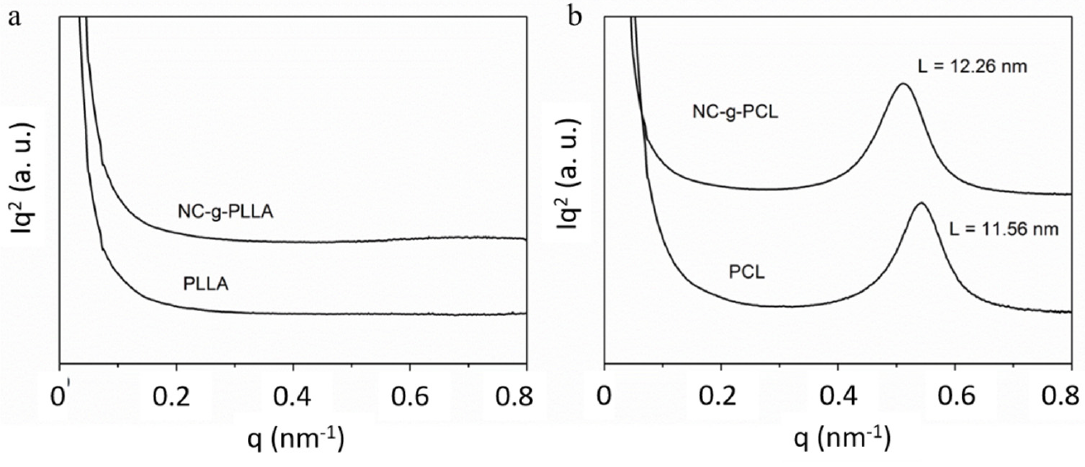
PCL for synthesized PCL). The calculated long period was slightly higher for NC-g-PCL.